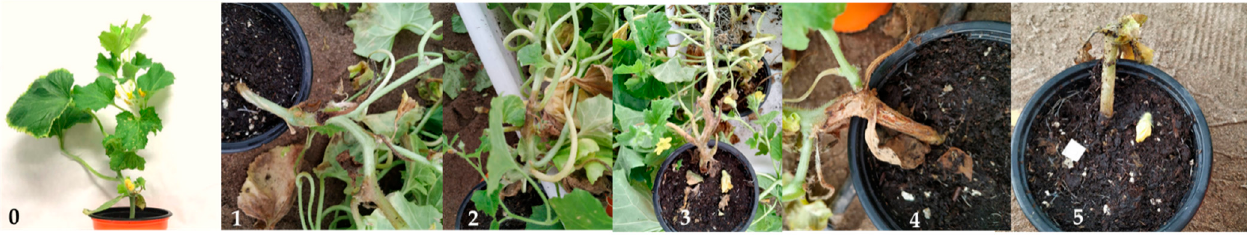
Figure 1. Example of the disease severity scale for M. melonis. 0 = healthy plant; 1 = initial symptoms; 2 = moderate symptoms (25%); 3 = affected plant (50%); 4 = severely affected plant (75%); 5 = dead plant.